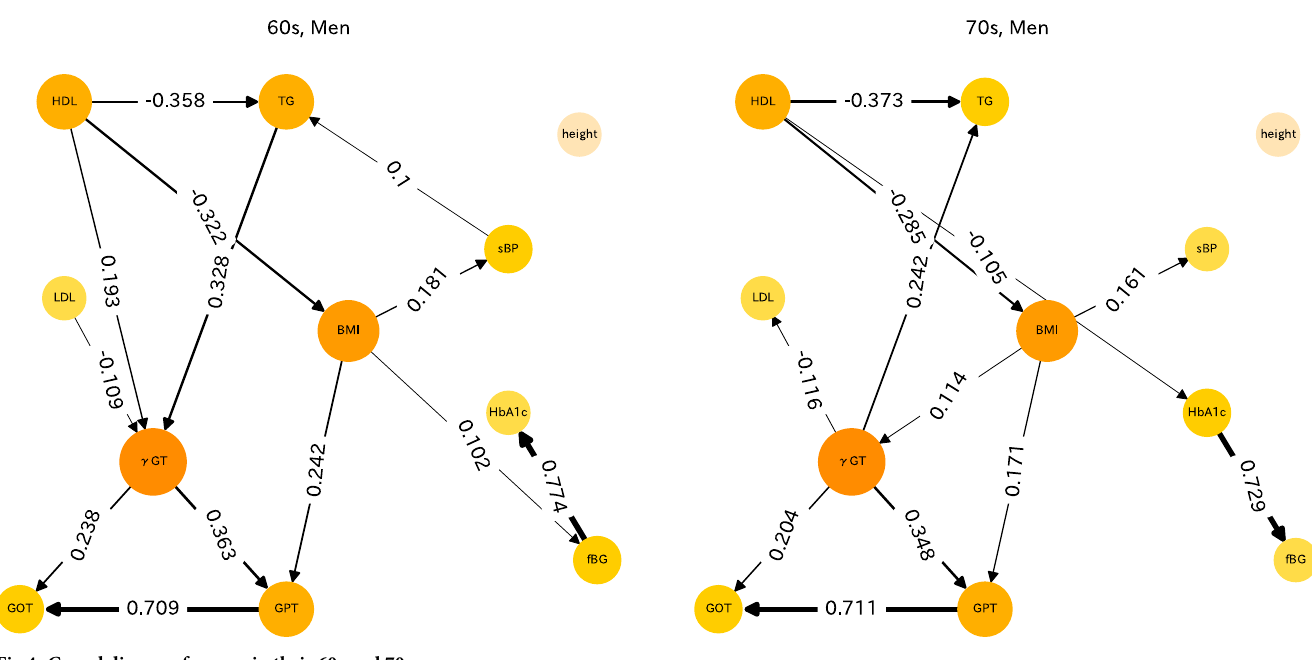
Fig 4. Causal diagram for men in their 60s and